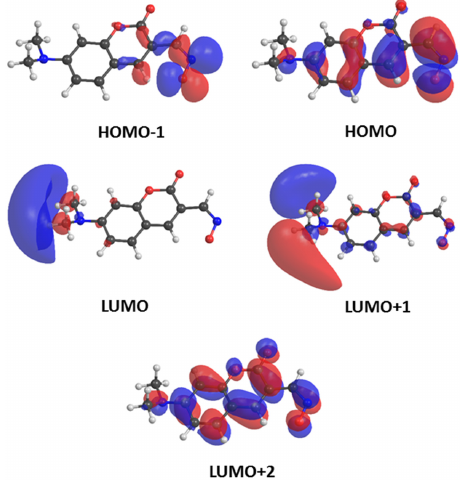
Figure 5. Molecular orbitals of most stable 7-dimethylaminocoumarin oximate 1 conformer (unusual shape of LUMO and LUMO+1 results mainly from combination of N(CH 3 ) 2 carbon 5s and 4p atomic orbitals; N(CH 3 ) 2 nitrogen 5s orbital also significantly contributes to LUMO molecular orbital).